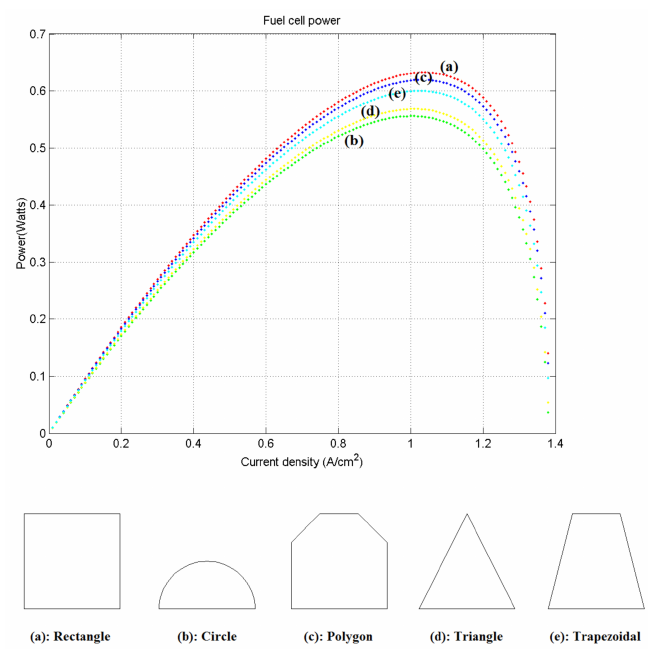
Figure 15. PEM-FC output effects of channel geometrical